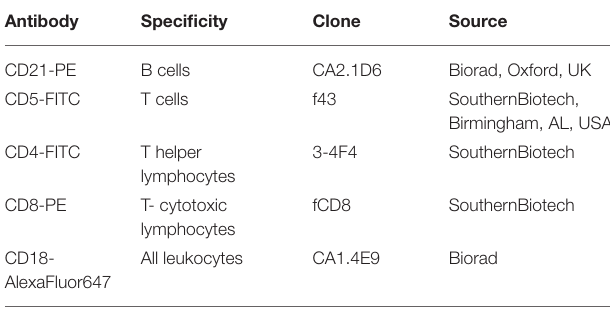
TABLE 1 | Panel of